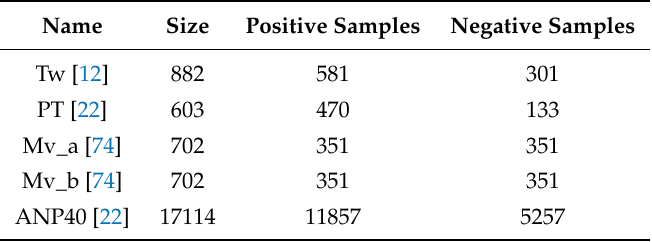
Table 4. Benchmarks adopted in the experimental sessions. Tw, Twitter; PT, Phototweet; Mv,